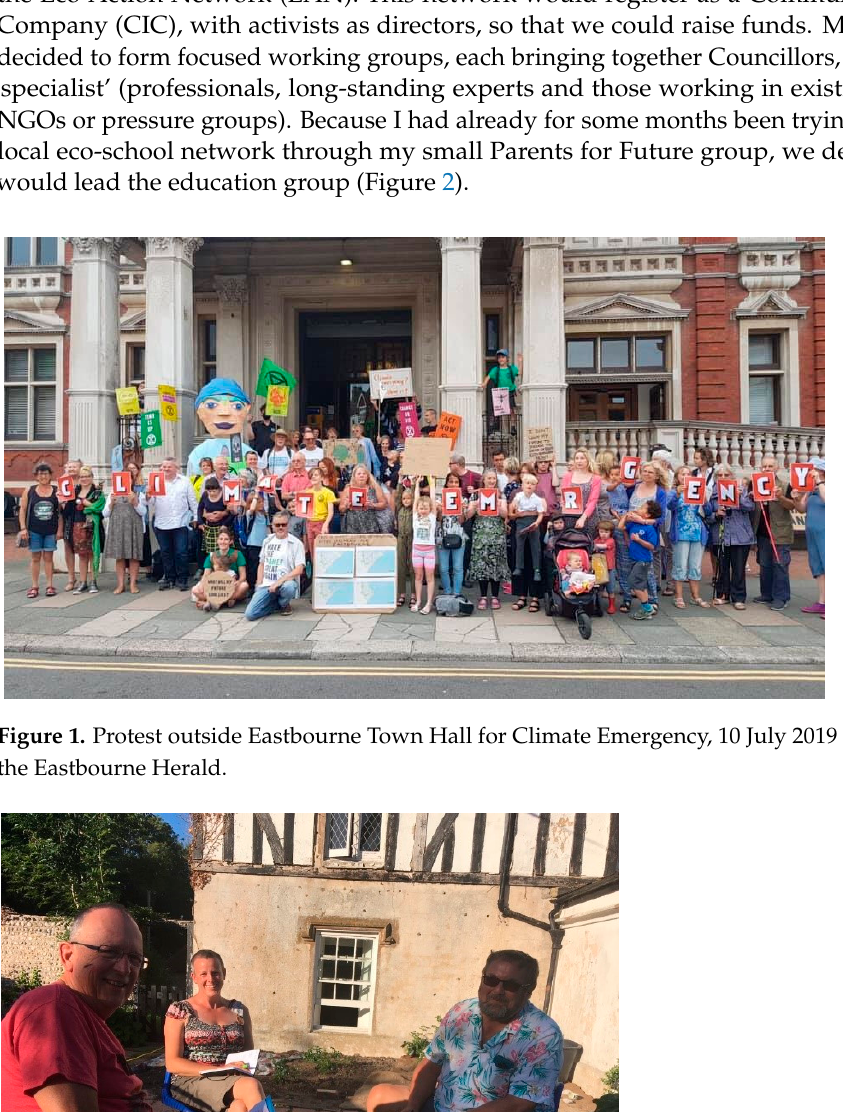
Figure 1. Protest outside Eastbourne Town Hall for Climate Emergency, 10 July 2019 @Courtesy of the Eastbourne Herald.